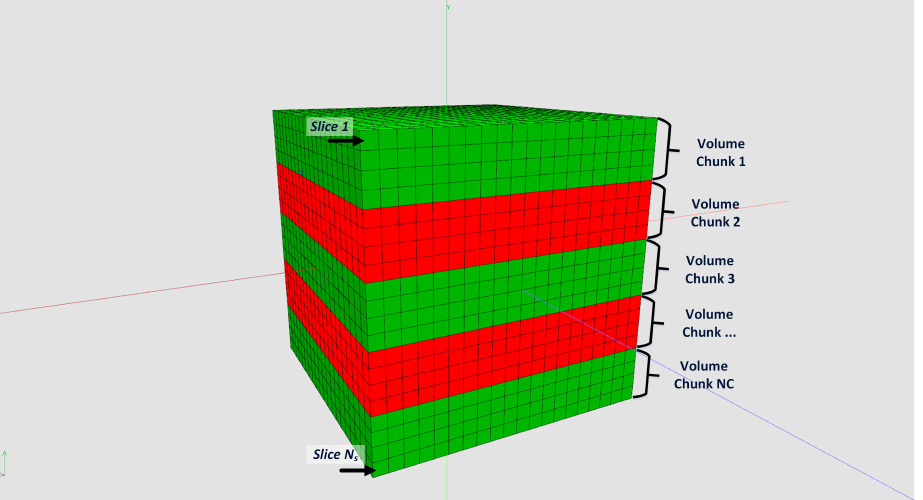
Figure 6. Splitting reconstruction volume into chunks, which are small enough to fit into CPU memory.